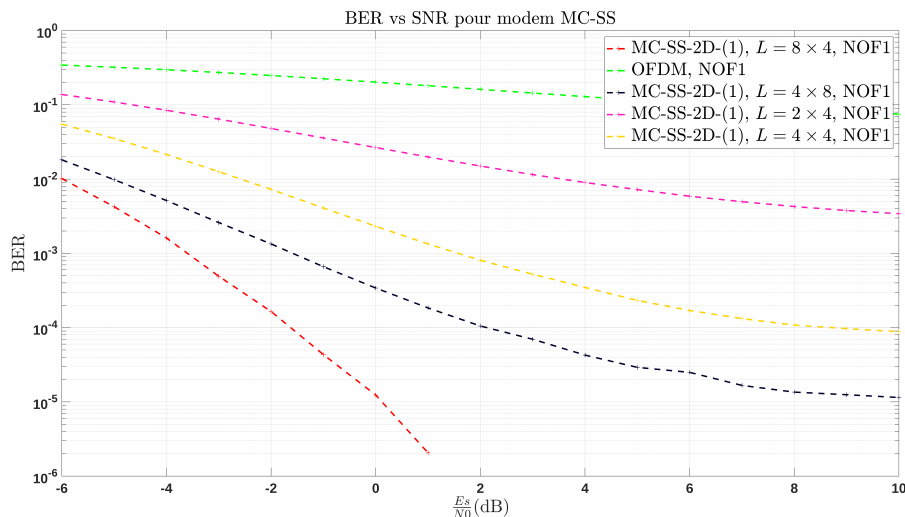
Figure 8. BER vs. Es for a communication on NOF1 channel (frequency passband: 10.5 kHz–14.5 kHz). N 0